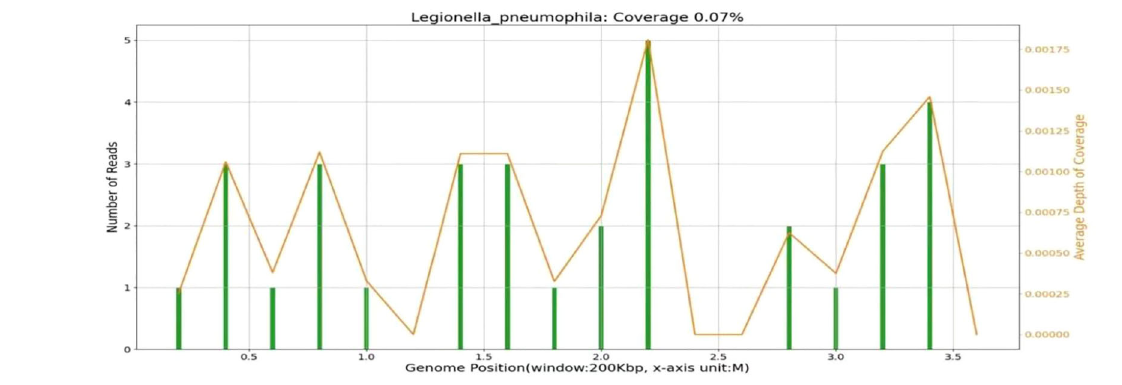
TABLE 2 L. pneumophila coverage from mNGS of the BALF